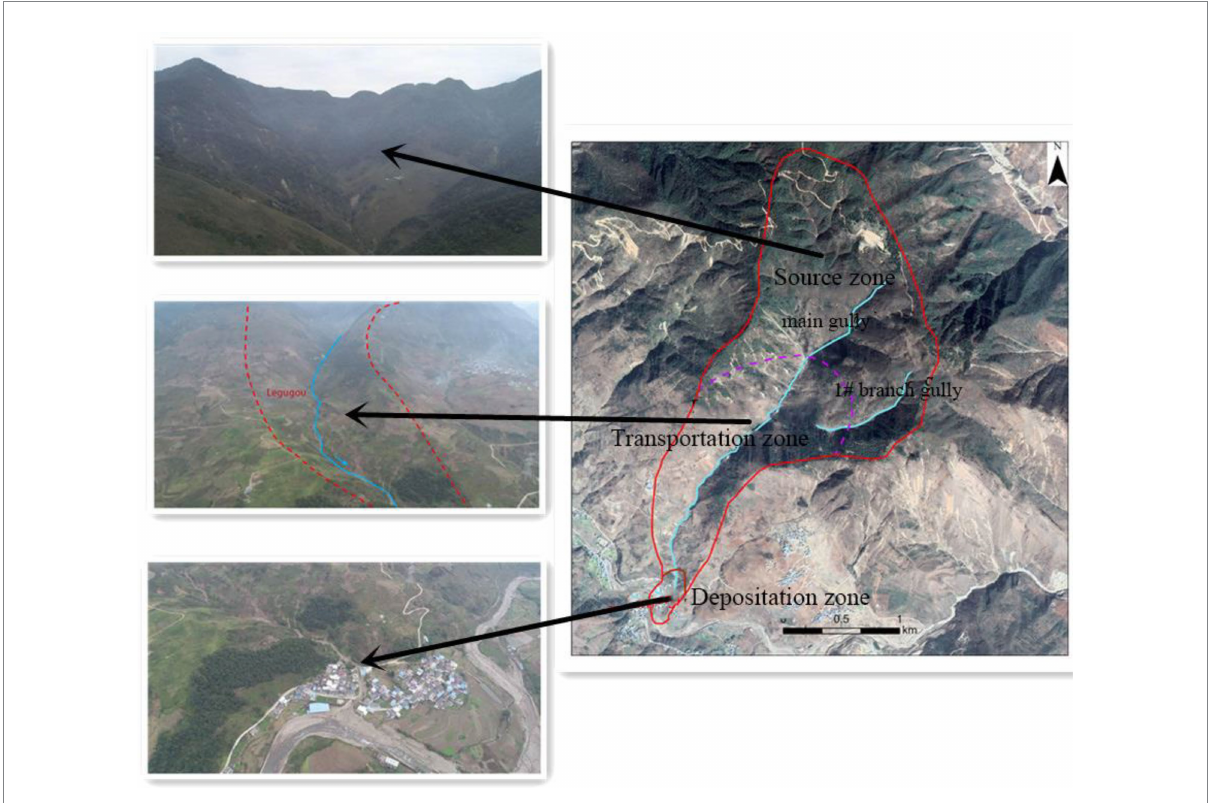
FIGURE 5 Zoning map of the watershed.